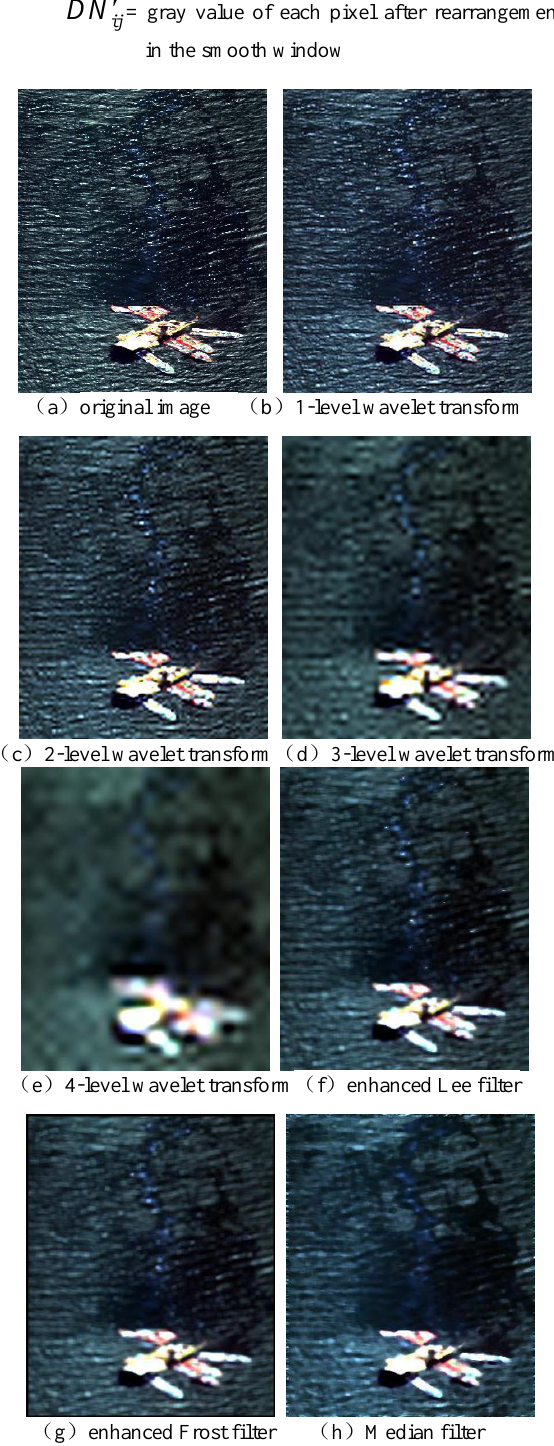
Figure 3. Different methods of sun glint suppression